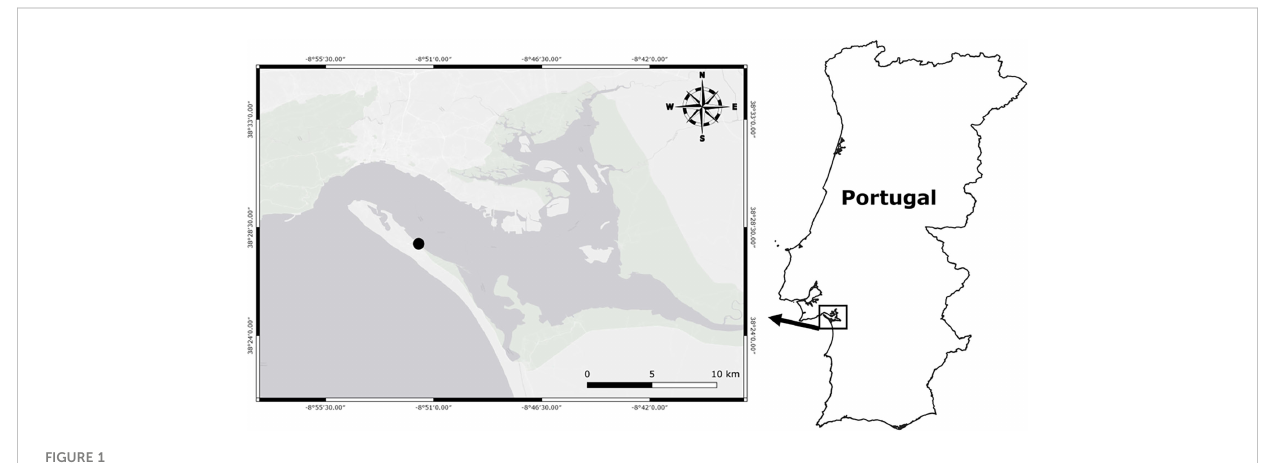
FIGURE 1 Field site